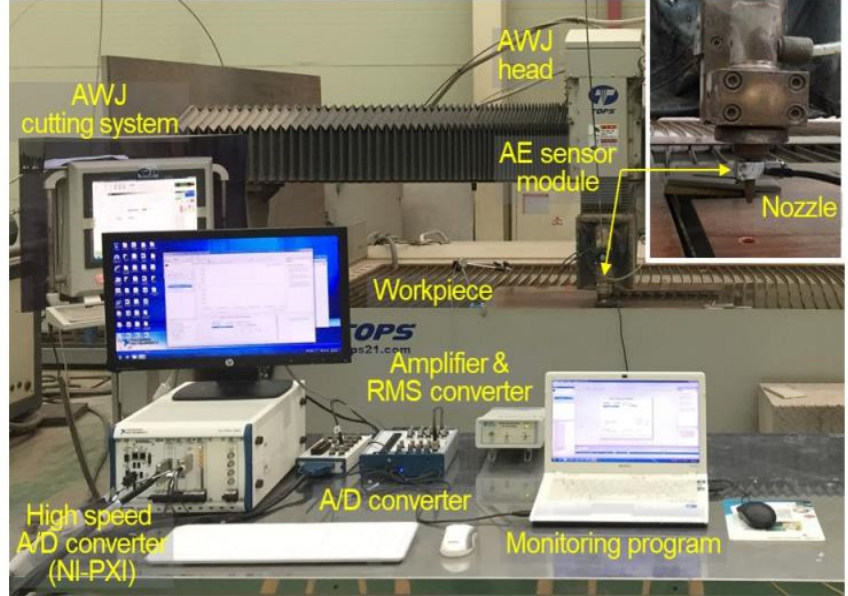
Figure 2. Experimental setup for the AWJ nozzle tests.